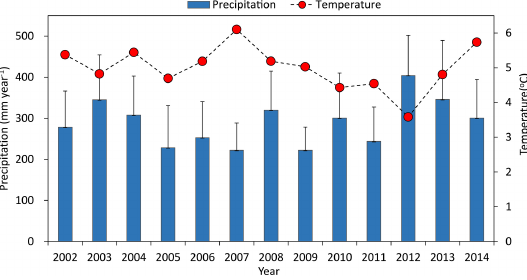
Figure 5. The annual total precipitation and mean temperature of 18 meteorology stations.